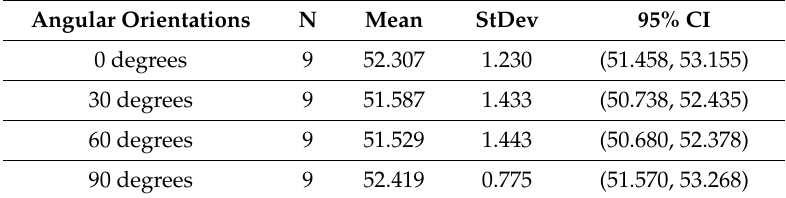
Table 16. Mean, standard deviation, and confidence interval for UTS as a function of angular orientations.